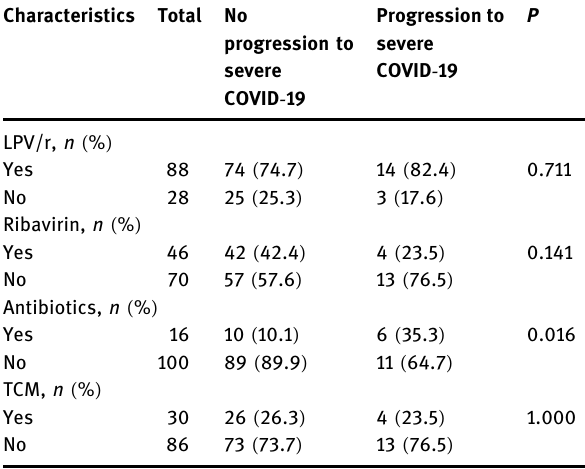
Table 4: Treatment of COVID - 19 patients within 14 days